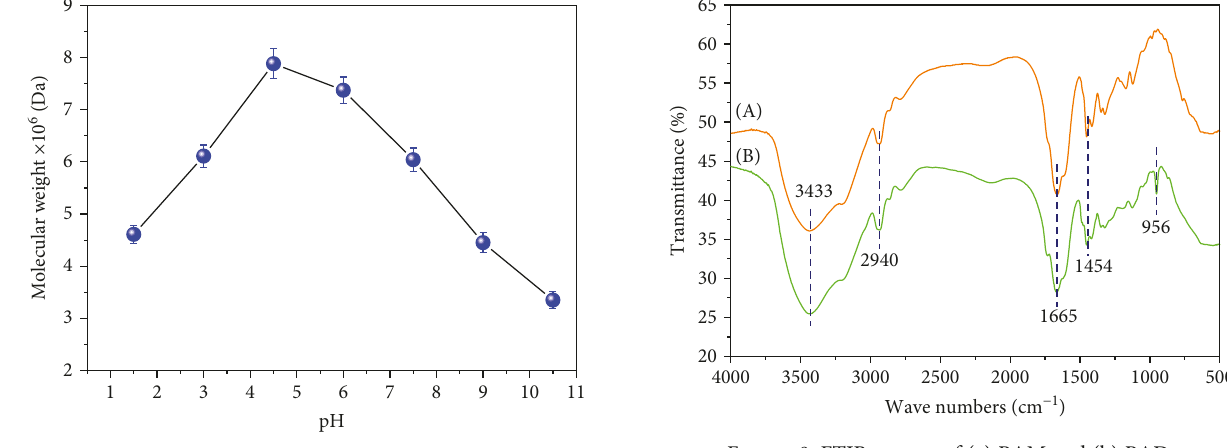
Figure 8: FTIR spectra of (a) PAM and (b)